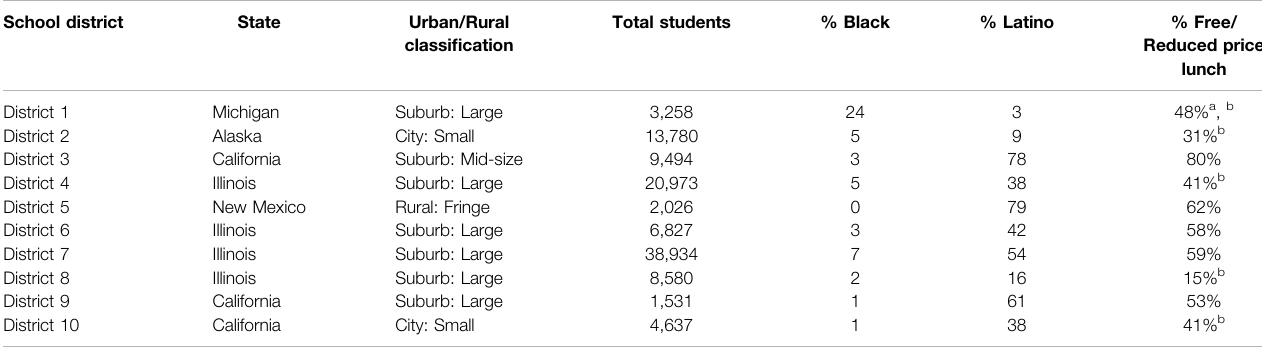
TABLE 1 | Characteristics of participating school districts.